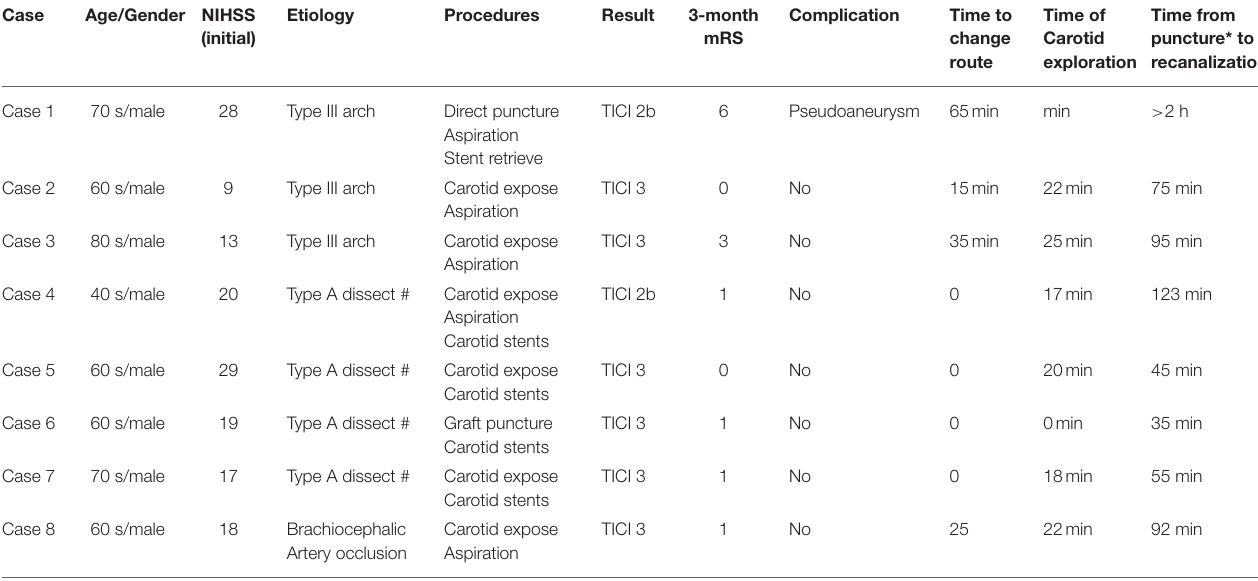
TABLE 1 | Clinical data of the patients who undergo transcarotid approach for acute cerebral infarction.